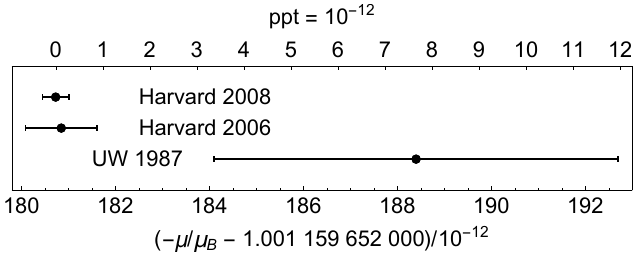
Figure 5. Comparison of the quantum determination of the electron magnetic moment with the only other measurement that fits on the same